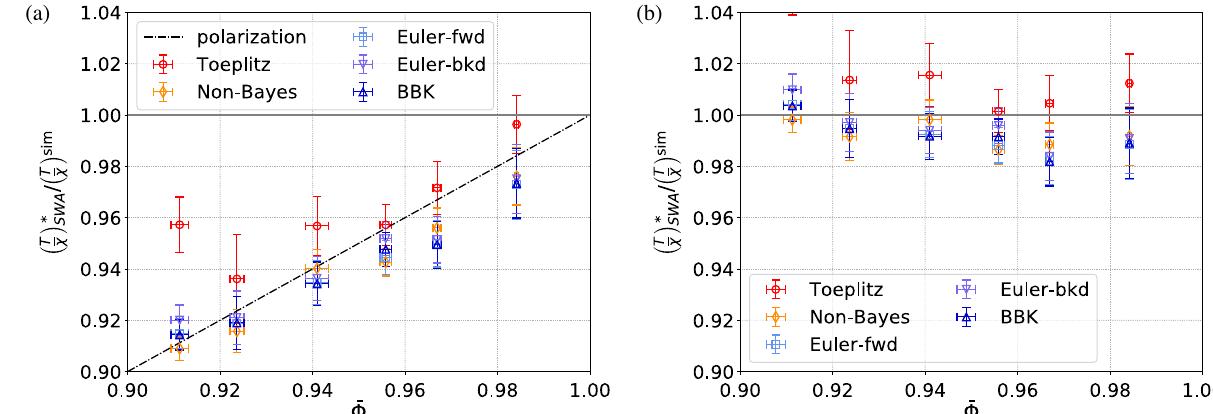
FIG. 9. First correction to the SWA. The comparison between the plots shows the effect of the SWA: In (a), the raw inferred values of T= χ , obtained using the inference formulas derived from Eq. (41), are reported. In (b), we include the first correction by rescaling the ¯ Φ output with the time-averaged polarization, for each sample trajectory. is the average of the averaged polarizations among different ¯ Φ simulated flocks, at any given temperature. Error bars for correspond to standard errors, whereas vertical bars represent, as in the other figures, 0.95